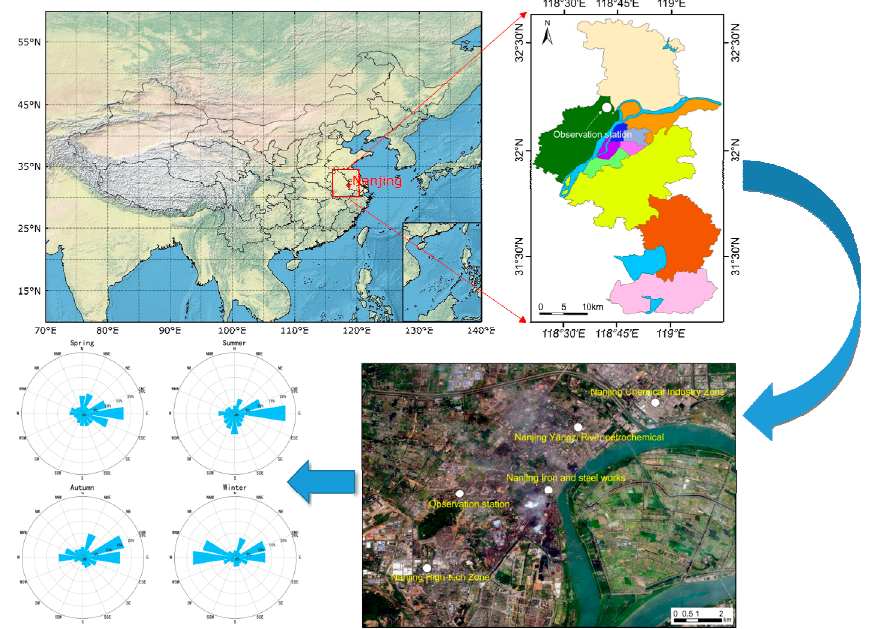
Figure 1. The location and surrounding environment of the observation site.